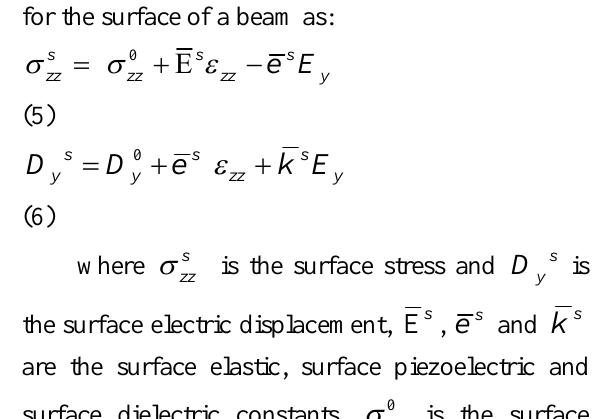
Fig. 1. (A) The hexagonal cross-section with surface layer (B) schematic diagram of